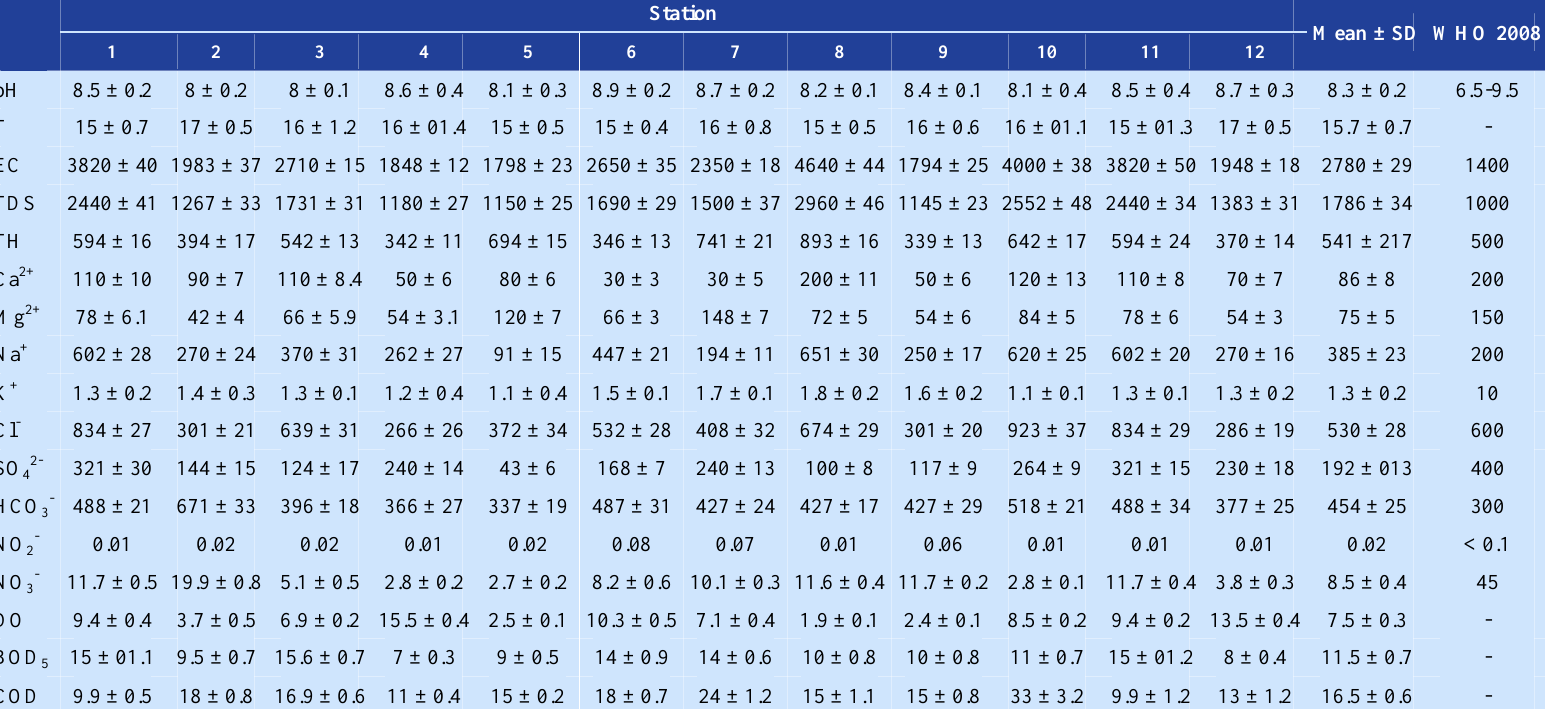
Table 2. Levels of the physico-chemical parameters (mean ± SD*) in surface water